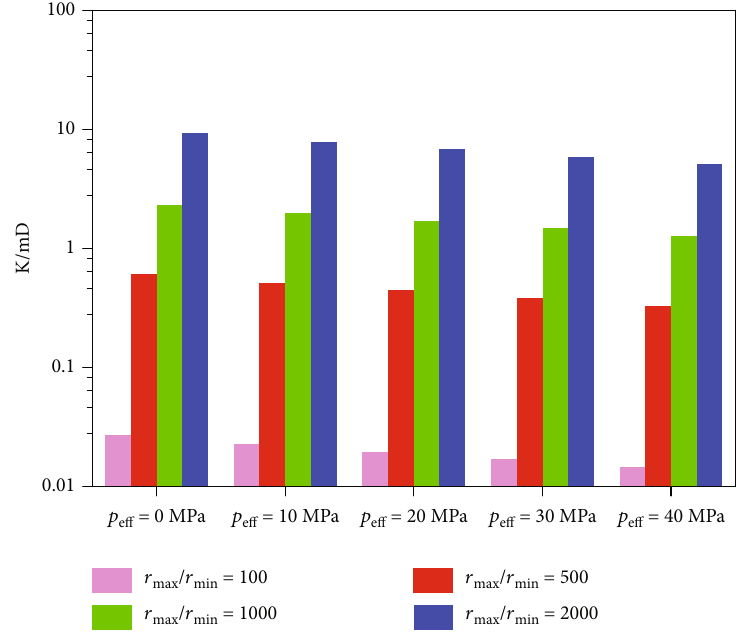
Figure 8: Permeability with di ff erent ratios of maximum pore radius to minimum pore radius.